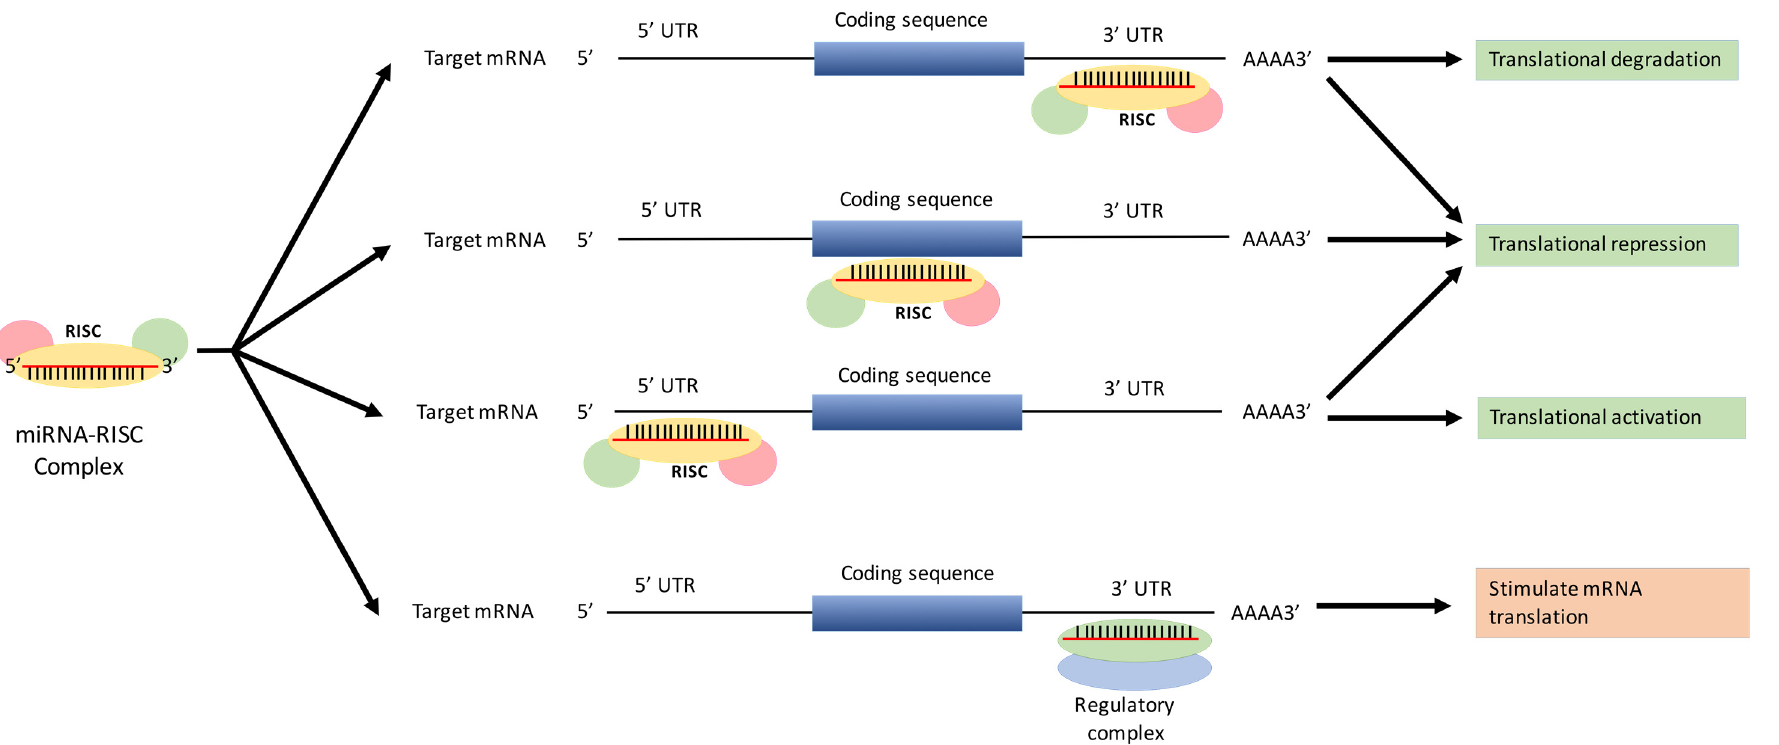
Figure 2. Function of miRNA in translational repression or activation of mRNAs.